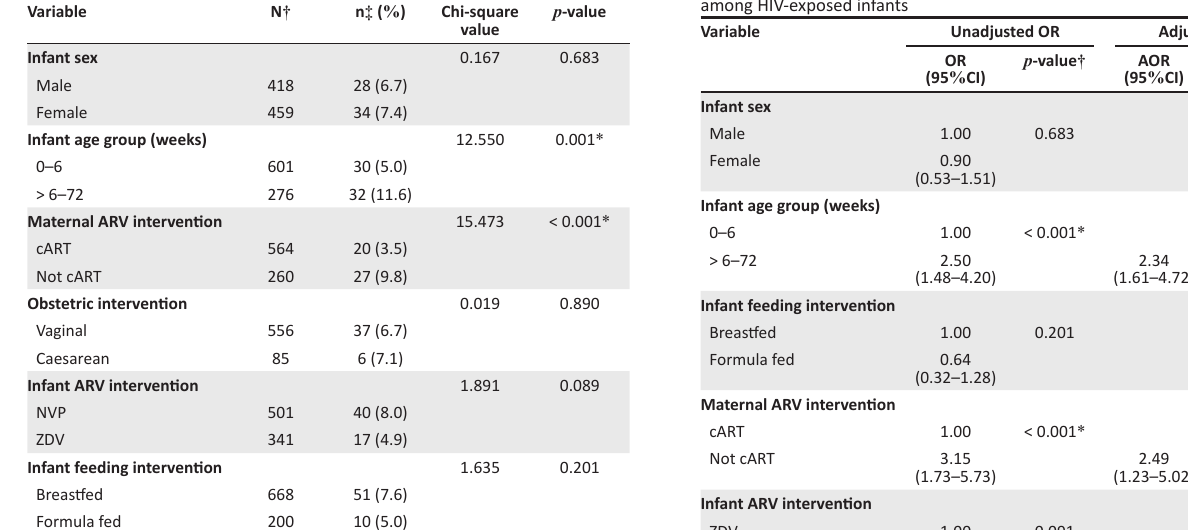
TABLE 1: HIV transmission among HIV-exposed infants – Univariable analysis Variable